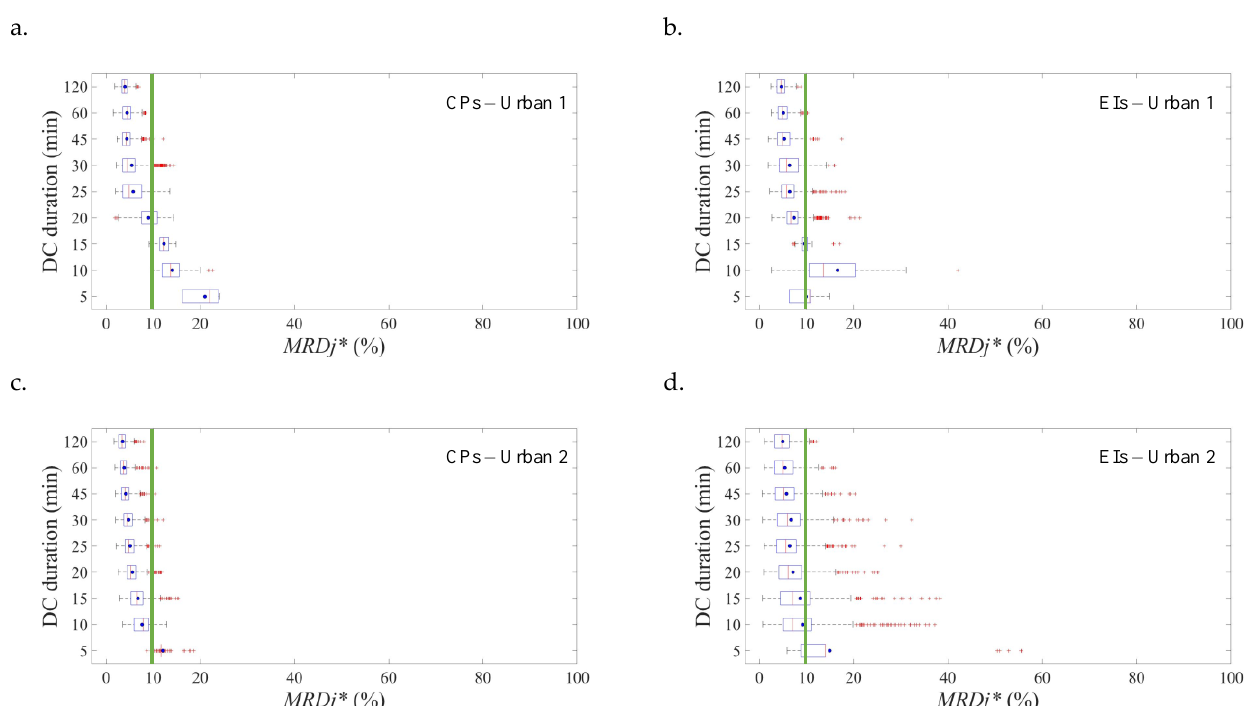
Figure 4. Results of 𝑀𝑅𝐷 𝑗 as a function of DC duration for the cases of ( a ) characteristic parameters and ( b ) Emissions in the Urban 1 region; ( c ) characteristic parameters and ( d ) Emissions in the Urban 2 region. Boxes indicate interquartile ranges, and red + signs indicate outlier data. Blue dots inside the boxes indicate the average value, while vertical red lines indicate the mean values ( 𝑀𝑅𝐷̅̅̅̅̅̅̅ ). The vertical green lines indicate threshold values for acceptable representativeness.